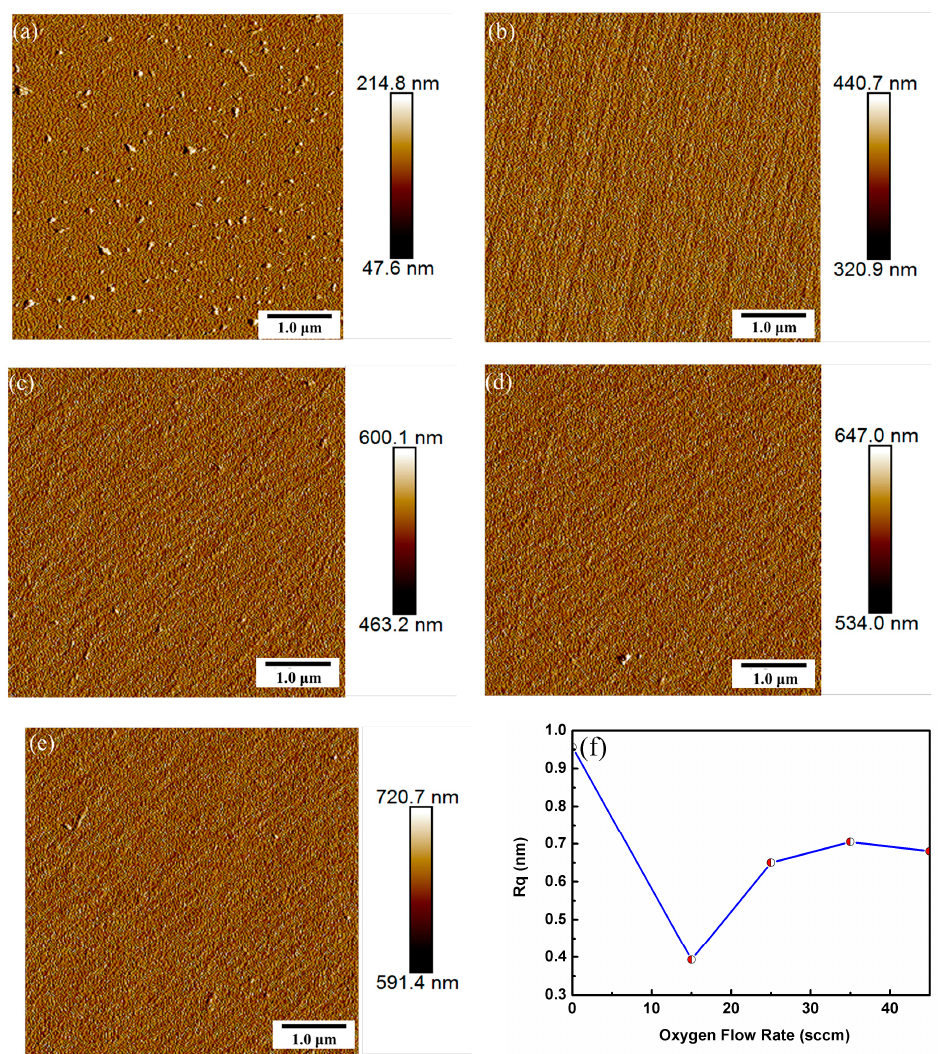
Figure 6. AFM images and R q of Sc 2 O 3 films deposited under different oxygen flow rates. ( a ) 0 sccm; ( b ) 15 sccm; ( c ) 25 sccm; ( d ) 35 sccm; ( e ) 45 sccm; ( f ) R q .